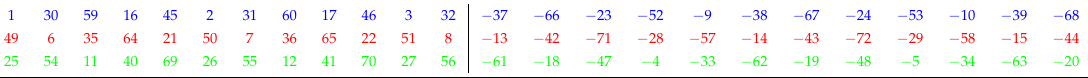
Table 16. Winding Distribution Table for a winding with N = 72, p = 5, m = 3 and q = 2 + 2 / 5 .